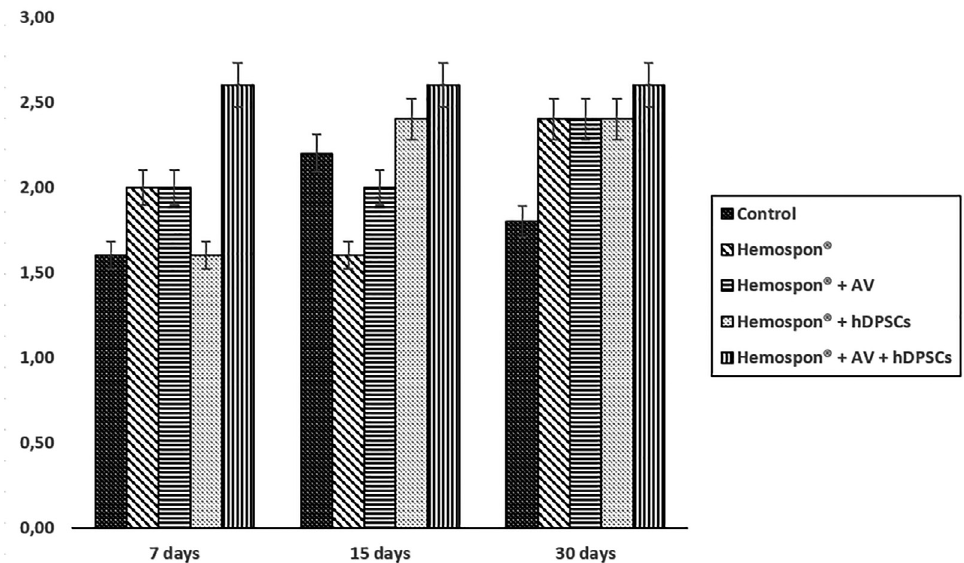
Figure 6- Average scores for the experimental groups’ bone formation in each evaluated